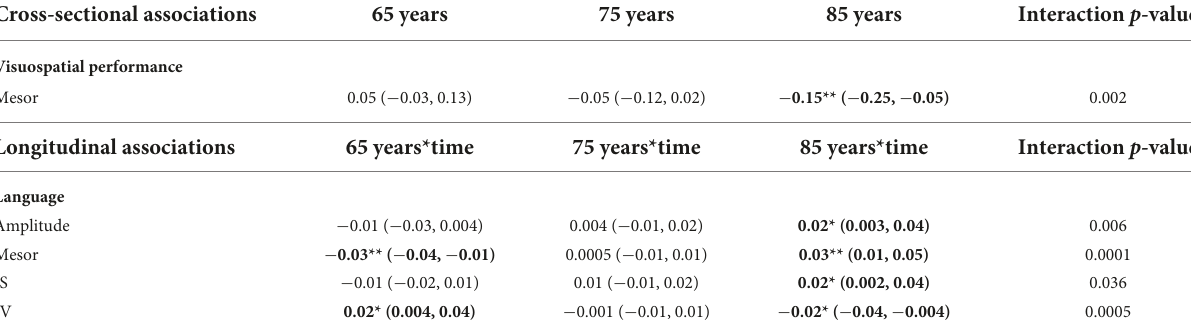
TABLE 11 Age: significant cross-sectional and longitudinal interactions with CRARs on cognition, estimated beta (95% CI). Cross-sectional associations